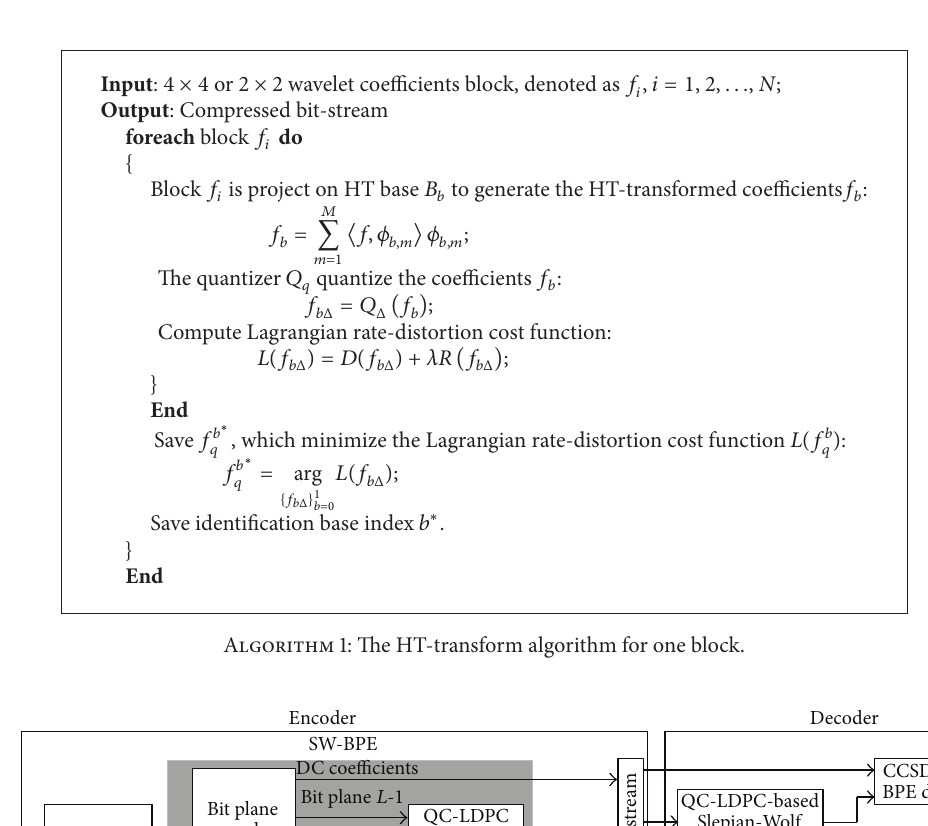
In decoding, the check bits combined with side informa- tion can be grouped together into new words to correct